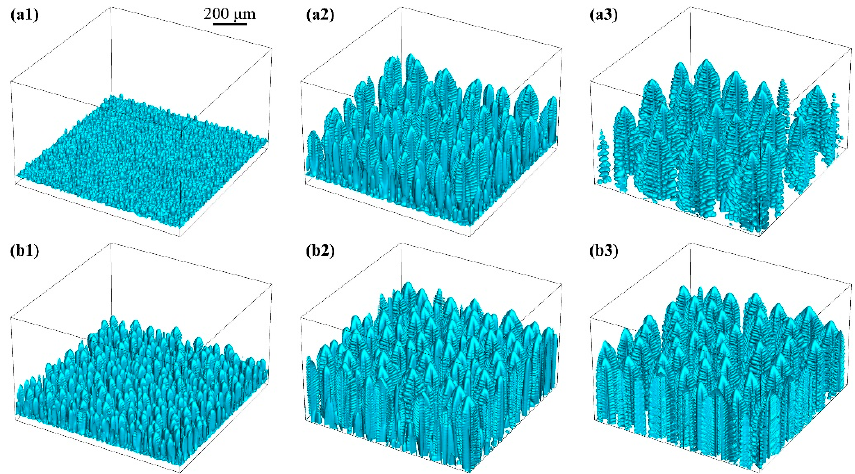
Figure 10. The dendrite morphology under HRS solidification process at time of ( a1 ) t = 10 s, ( a2 ) t = 15 s, ( a3 ) t = 100 s; and under LMC solidification process at time of ( b1 ) t = 5 s, ( b2 ) t = 7.5 s and ( b3 ) t = 100 s.